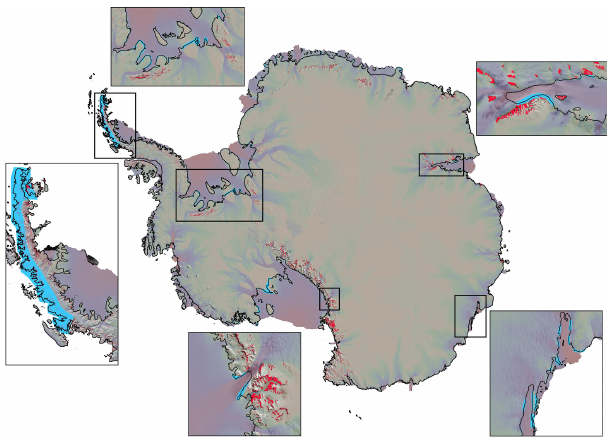
Figure 2. Antarctic ice sheet velocities overlain on the MODIS Mo- saic of Antarctica (Scambos et al., 2007). Areas of imposed zero change in velocity are shown in cyan. Areas of prescribed zero sur- face velocity (rock outcrops) are shown in red as defined according to the Antarctic Digital Database